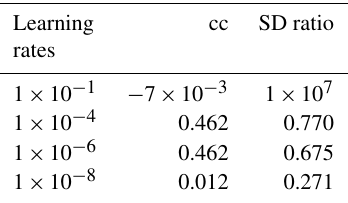
Table B2. Different learning rates using Huber loss, with the rest of the parameters fixed as in Table B1.